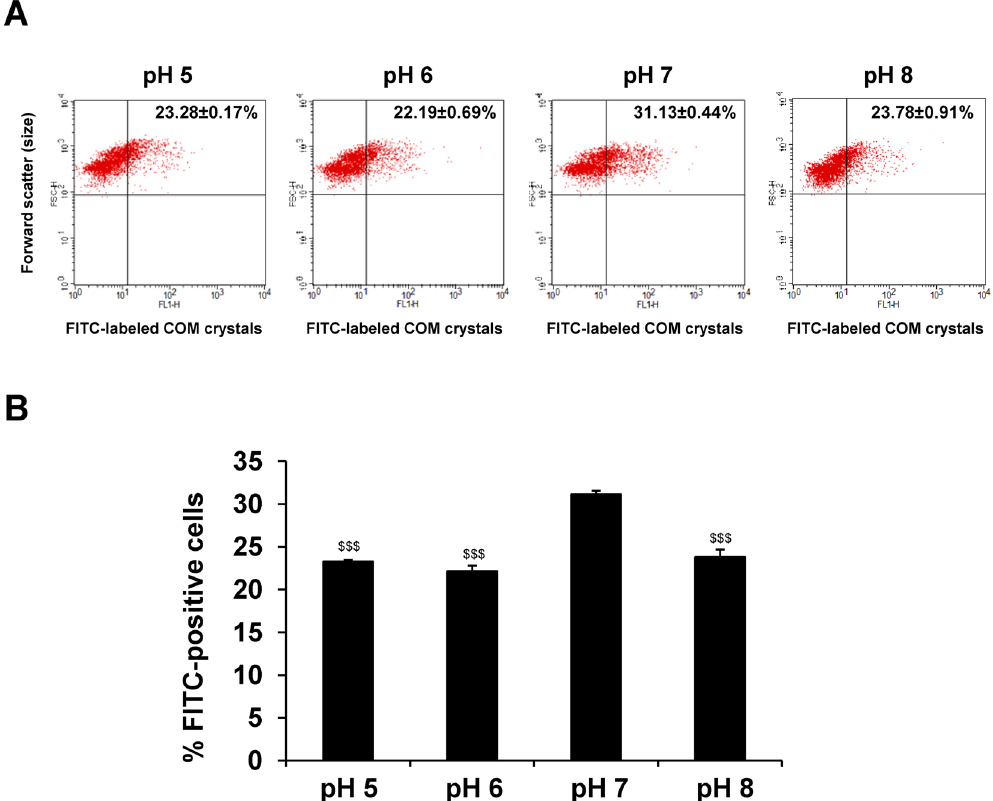
Figure 6. Effect of pH on internalization of COM crystals into renal tubular cells. Crystal internalization assay was performed using FITC-labelled COM crystals under varying pH (from 5.0 to 8.0). ( A ) Representative flow cytometric data of the internalized FITC-labeled COM crystals that were endocytosed by MDCK cells under varying pH conditions. ( B ) Quantitative data of FITC-positive cells. The data are reported as mean ± SEM of the data obtained from 3 independent experiments. $$$ p < 0.001 vs. pH